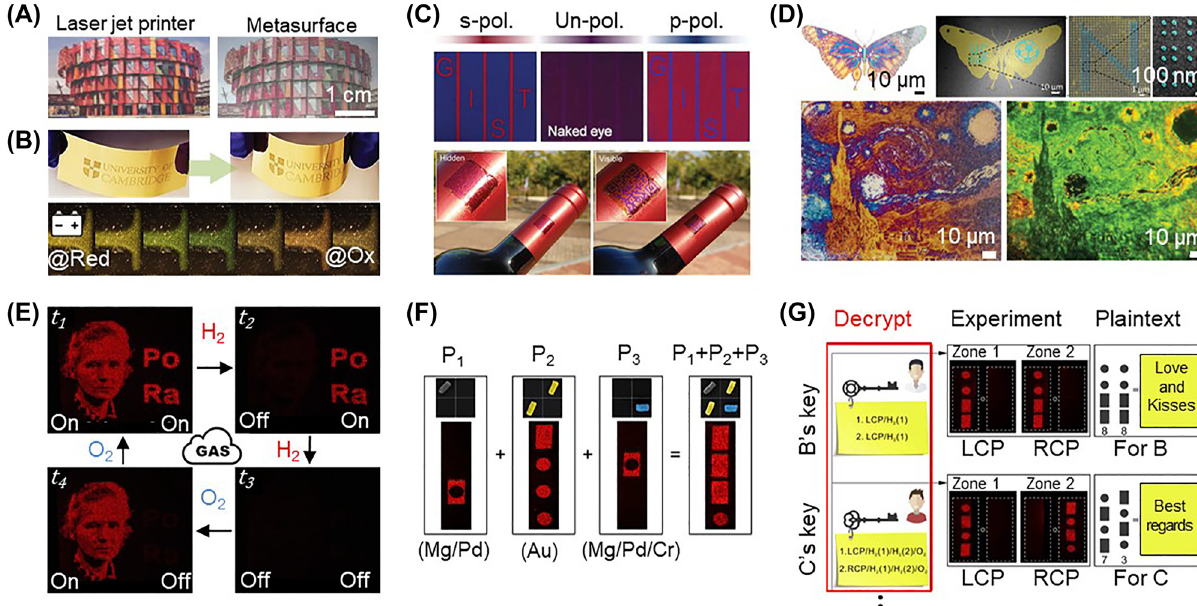
Figure 9: Emerging applications of plasmonic and hybrid nanopixels: (A – B) flexible electrochromic displays using (A) plasmonic nanohole metasurface and (B) plasmonic Au nanoparticle-on-mirror construct fi lled with conductive polymers (reproduced with permission [125, 198], Copyright2021,Wiley-VCHand2020,AmericanChemicalSociety),(C – D)informationencryptionwith(C) slantedGe nanorodsforpolarization dependent coloration and (D) multilayered plasmonic nanostructures with embedded upconversion nanoparticles for light wavelength dependent coloration (reproduced with permission [198, 199], Copyright 2020, Wiley-VCH and 2019, Wiley-VCH), and (E) active holograms usingMgplasmonicmetasurfacefor(F – G)gasresponsiveinformationencryption(reproducedwithpermission[78],Copyright2018,American Association for the Advancement of